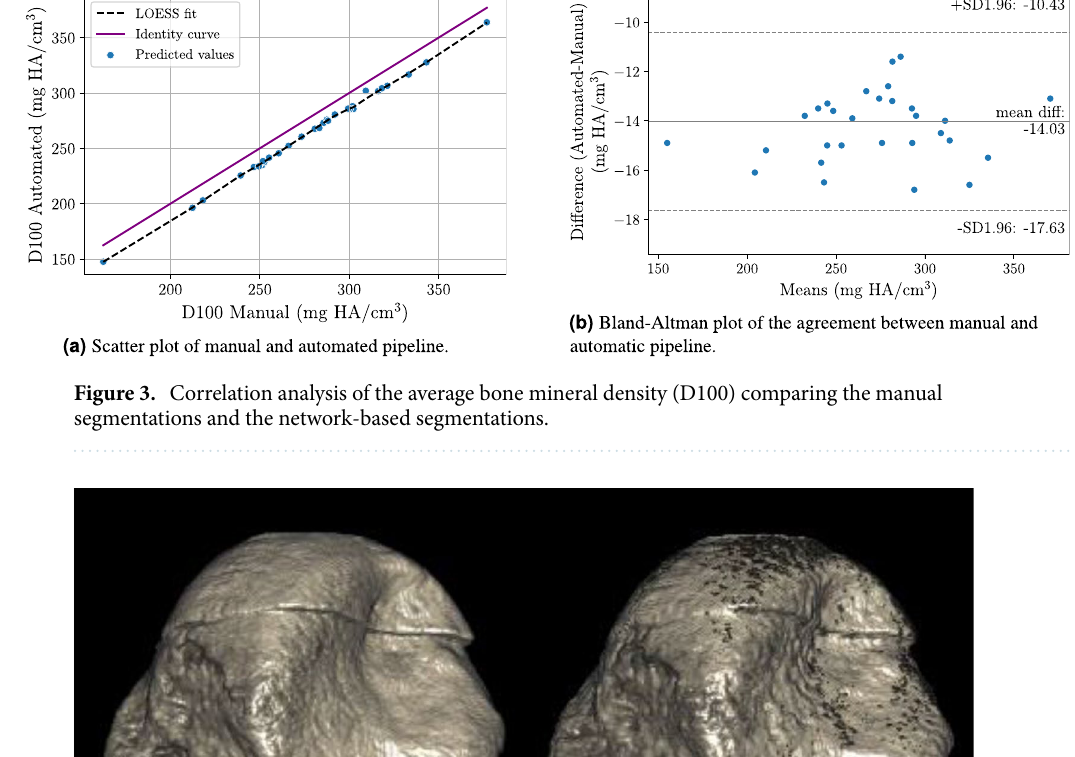
Image acquisition. The image acquisition was equal for the manual and the fully automatic pipeline. However, in order to compare the two pipelines, all the respective steps have to be considered for a complete comparison of the time requirements. The fixation and the scanning of the patient’s hand took 8.4 min 16 . Segmentation. For the 2D U-Net, the network-based pipeline took on average 33.45 s (SD 0.08). The 3D U-Net slightly surpassed the 2D U-Net with an average of 32.98 s (SD 0.09). The comparison of the semi-automatic segmentation and the network-based segmentation is shown in Table 2 in the Segmentation row. vBMD calculation. The last step of the clinical workflow is the calculation of the volumetric bone mineral den- sity. Similar to the image acquisition, this step did not differ for the automatic and the manual pipeline. Based on values of the calibrated images. The calculation of the vBMD for the segmented bone consists of the summation of the corresponding voxels in the calibrated images. On average, this step takes 1 min 18 .